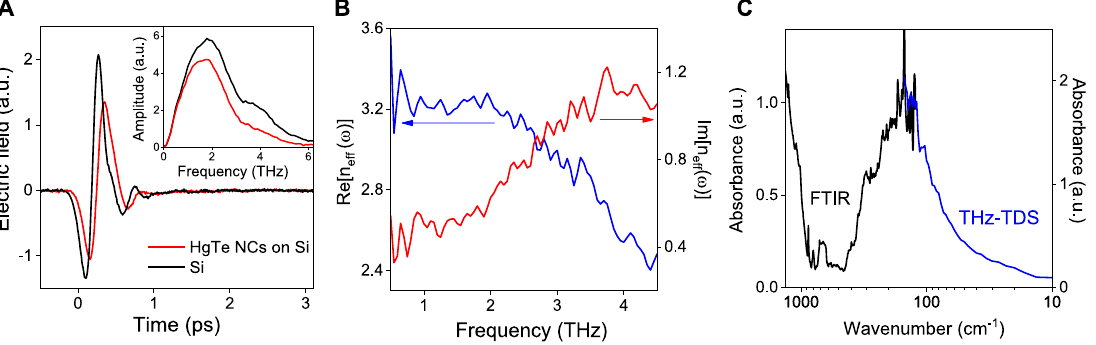
Figure 2: (A) The electric fields of the THz pulses transmitted through the HgTe composite film sample (red line) and through the Si substrate reference sample (black). Inset: corresponding amplitude spectra obtained by fast Fourier transform of the temporal traces. (B) The real and imaginary part of the effective index ˜ n eff ( ω ) of the composite fi lm composed by the NCs and their surrounding environment is made of dodecanethiol ligands and air. (C) Absorbance spectra from 1330 cm − 1 to 10 cm − 1 of the HgTe sample obtained by THz TDS (blue line) and FTIR (black line) measurements. The FTIR data are arbitrarily matched to the TDS one in their overlapping spectral region, as measurements were performed